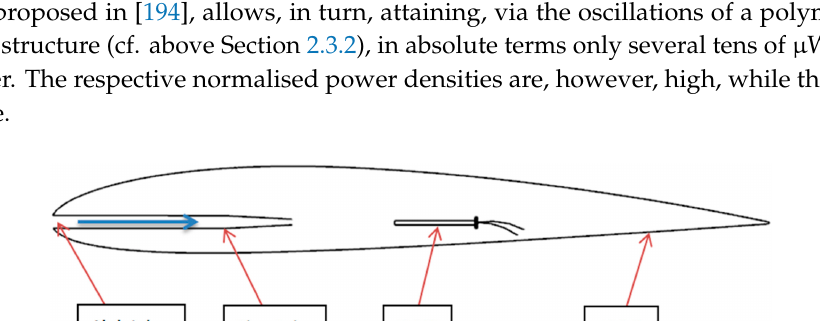
Figure 33. Scheme of jet-edge EH device in an aerofoil [194]-licensed under a Creative Commons Attribution (CC BY).